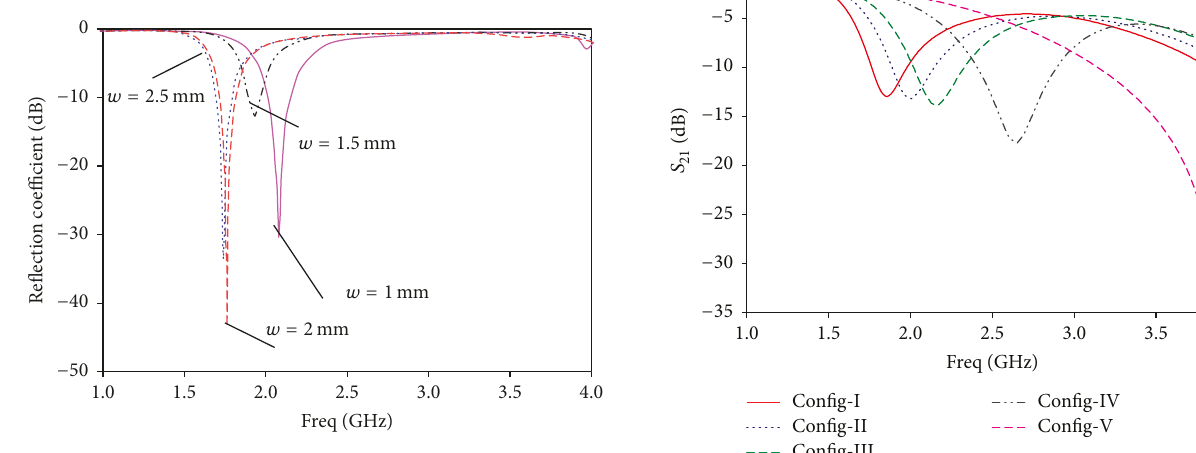
Figure 8: Resonance frequency variation for different slot widths.